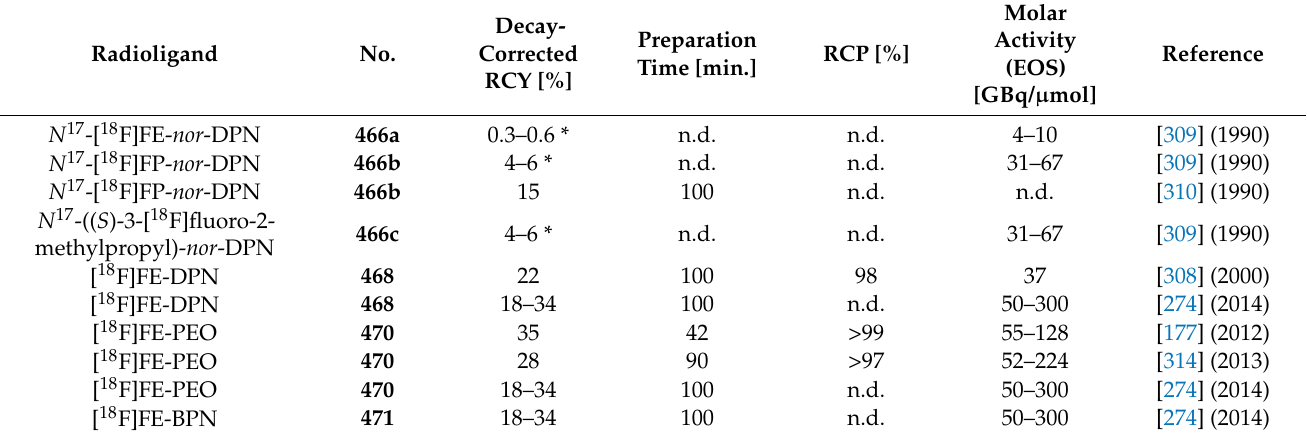
Table 5. Radiosynthesis data of fluorine-18 labelled orvinol